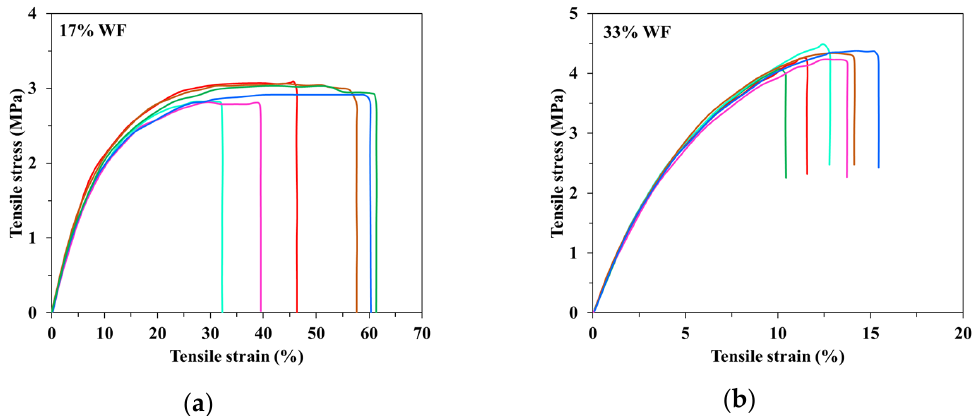
Figure 6. Influence of the wood flour concentration on the stress–strain behaviour of the quaternary starch-based blends ( a ) 15% ; ( b ) 30%.